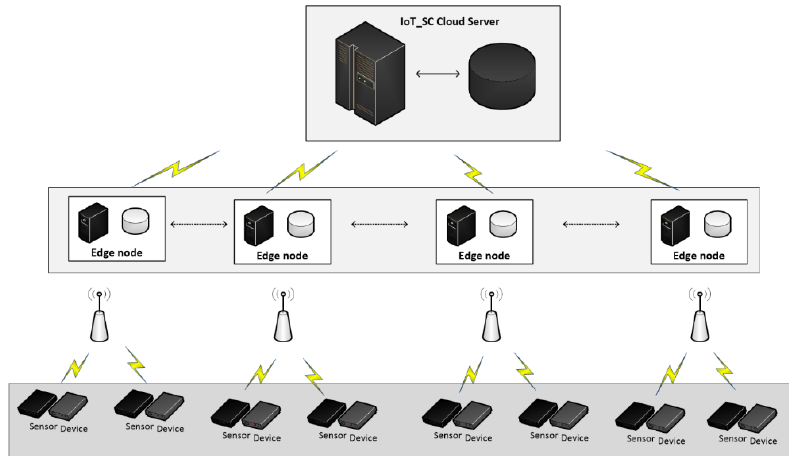
Figure 1. IoT-based supply chain system.